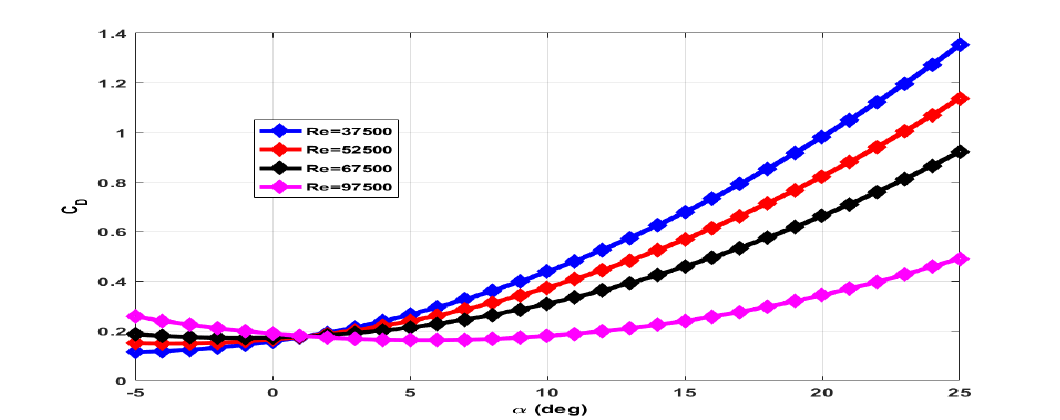
Figure 11. Coefficient of drag at + 15 ◦ elevator deflection and zero propeller RPM.